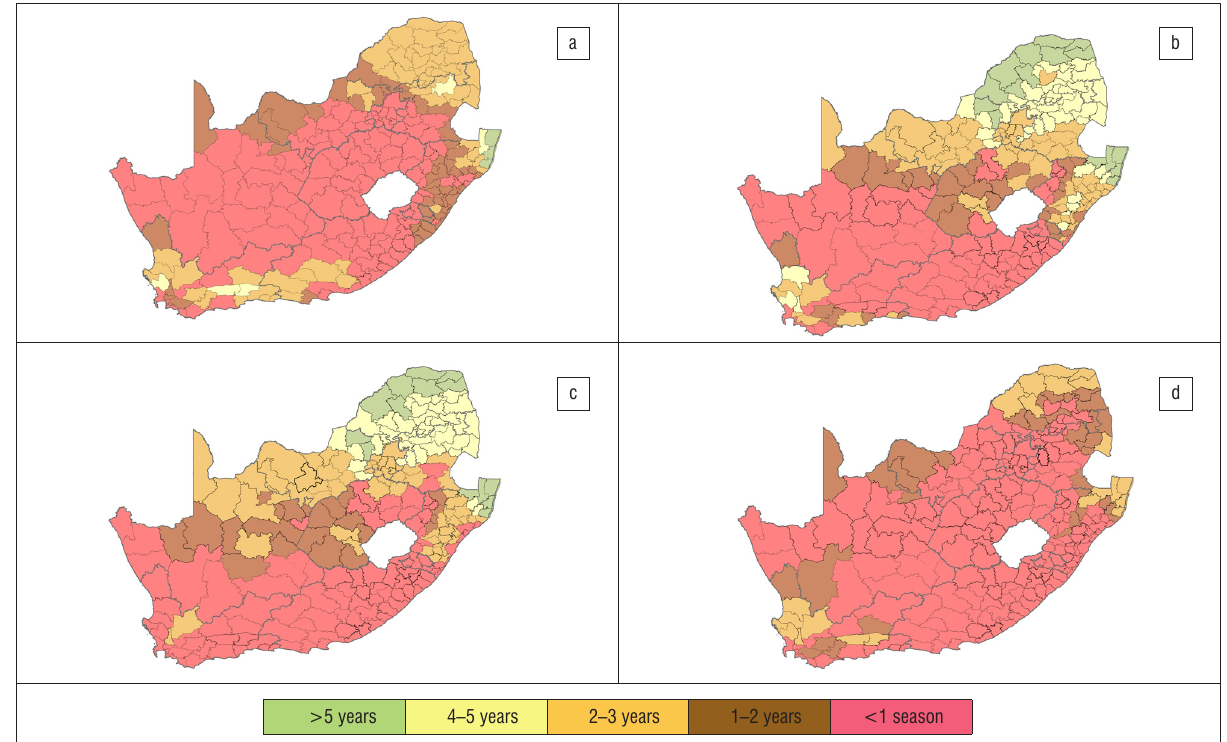
Figure 6: Predictability per season, defined as the estimated return period in years of a wind gust of 20 m/s or higher: (a) Summer (DJF), (b) autumn (MAM), (c) winter (JJA) and (d) spring